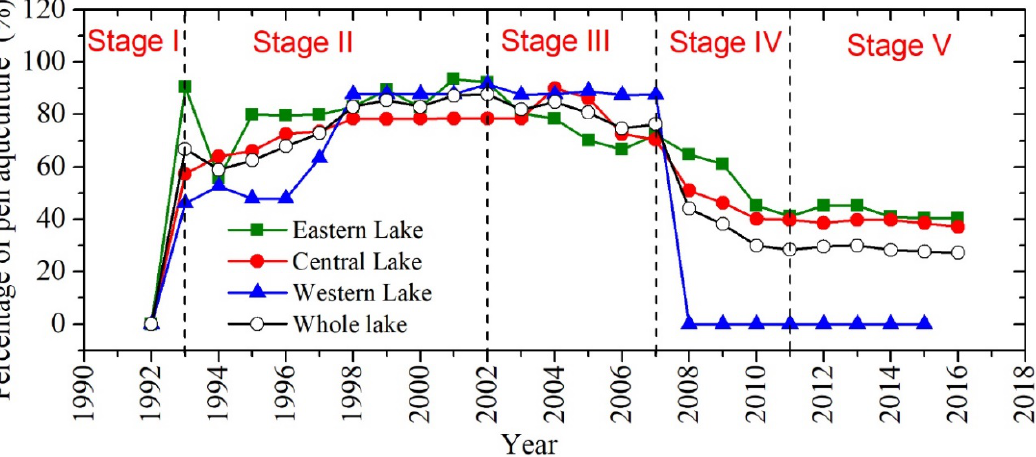
Figure 6. Area changes in pen aquaculture area from 1992 to 2016 in the Western, Central and Eastern Lakes.